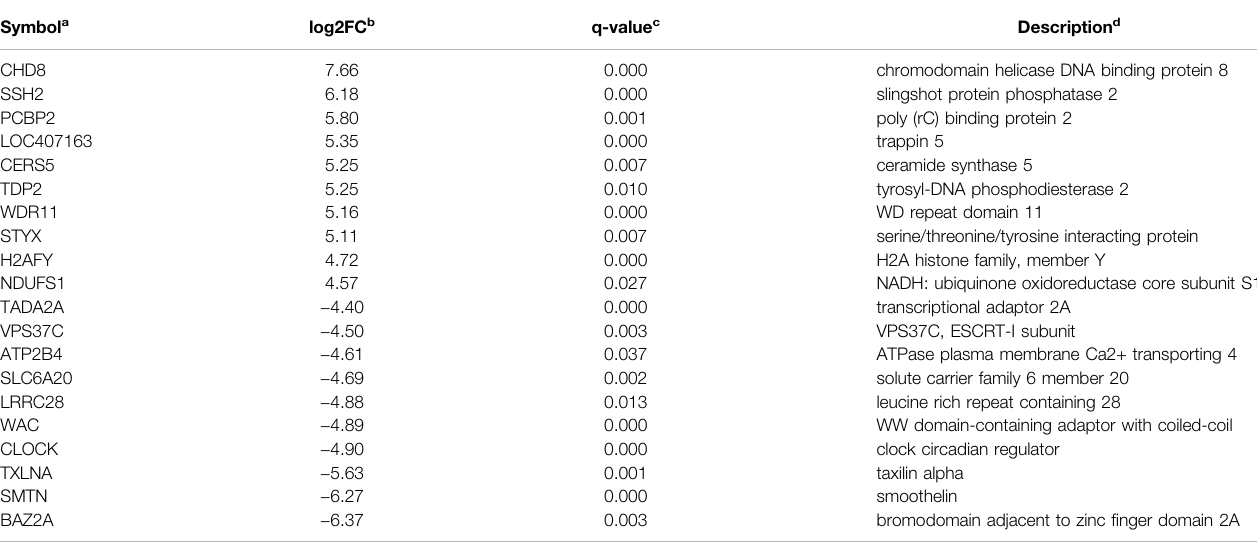
TABLE 2 | Top ten upregulated and downregulated DEGs in LRFI group compared with HRFI group.